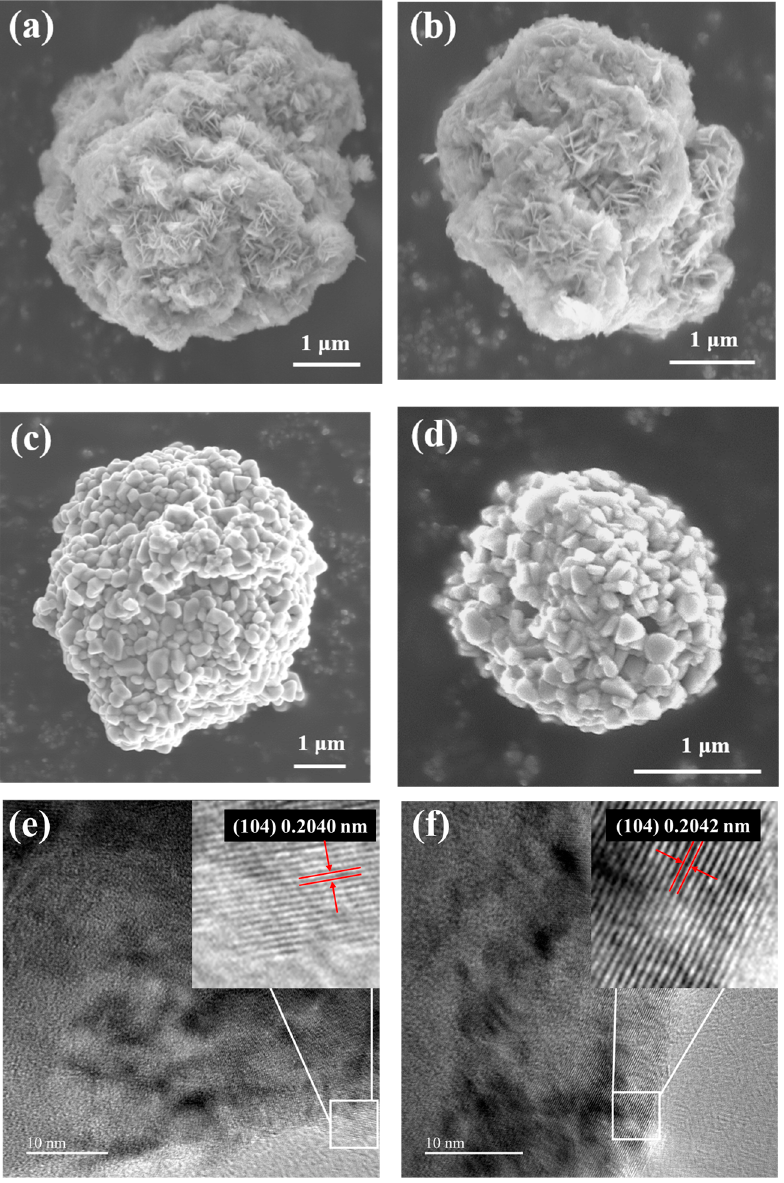
Figure 2. SEM images of ( a ) CC-NCMOH, ( b ) CG-NCMOH, ( c ) CC-LNCMO and ( d ) CG-LNCM; HRTEM images of ( e ) CC-NCMOH and ( f ) CG-NCMOH.